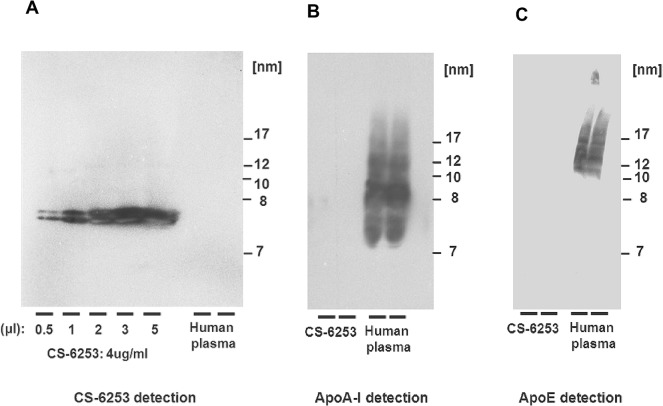
Cross reactivity characterisation of anti-CS-6253 antibody.Non denaturing gradient gel electrophoresis (4–20%) is used to separate CS-6253 complexes, apo A-I and apo E. CS-6253 was immunoblotted using antibody against human apo A-I, human apo E and against CS-6253. Normolipidemic human plasma was used as positive control. Molecular weight markers were revealed by Ponceau S. Left panel shows dose response relationship with an antibody directed against CS-6253. Middle panel shows anti-apo A-I antibody does not cross-react with CS-6253; similarly, right panel shows antibody against apo E does not react against CS-6253.